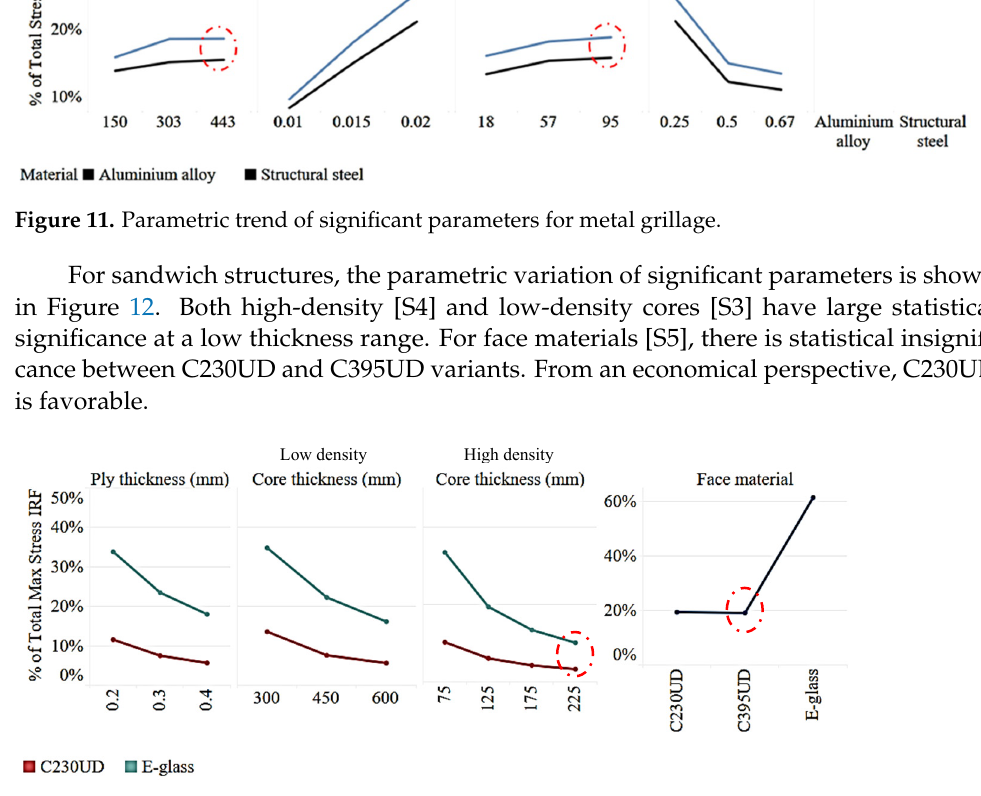
Figure 12. Sensitivity Analysis of parameters for sandwich panel stress safety factor.